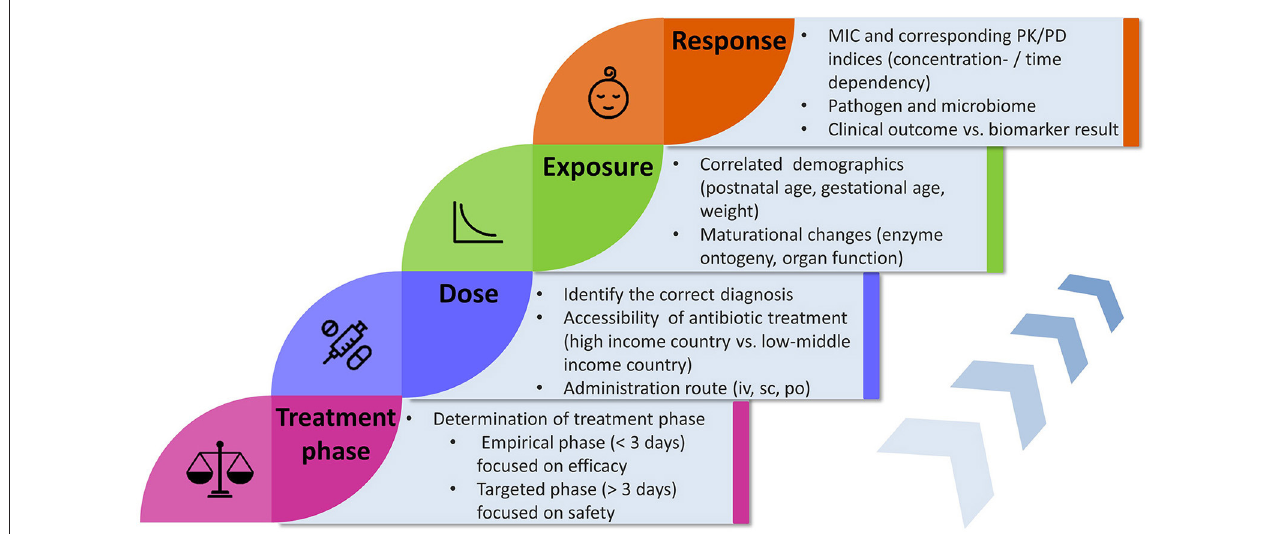
FIGURE 1 | Flowchart illustrating key components and factors influencing the concepts concerning antibiotic treatment in neonates and infants. MIC, minimal inhibitory concentration; PK, pharmacokinetics; PD, pharmacodynamics; iv, intravenous; sc, subcutaneous; po, oral.